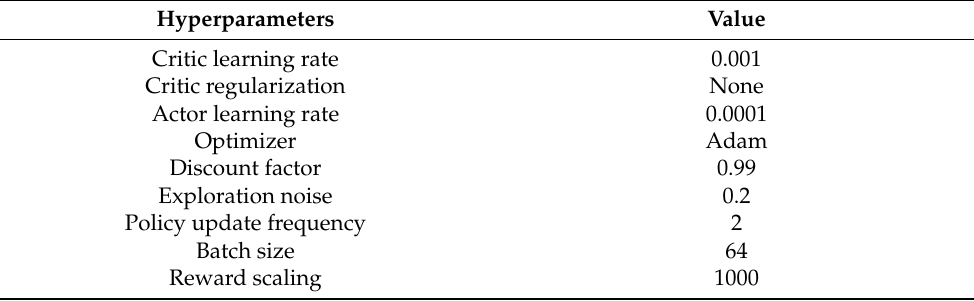
Table 2. Primary hyperparameters of LSTR–TD3 algorithm.